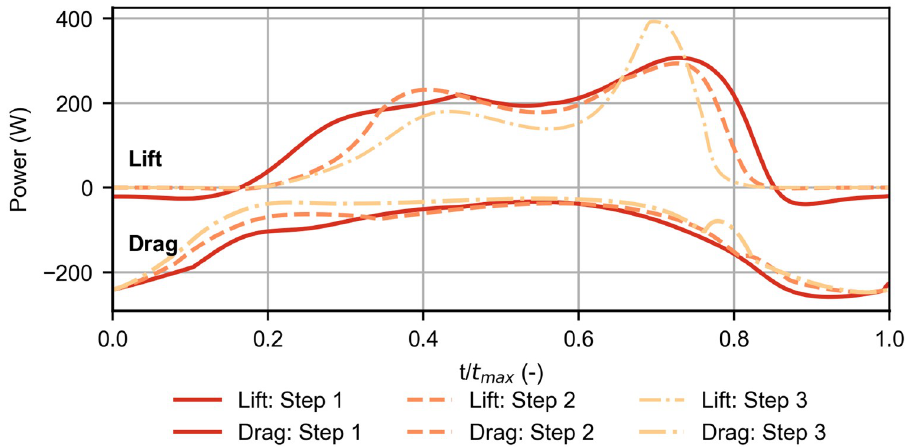
Fig 10. Effect of the transition height. Evolution of energy rates associated to lift and drag, for different transition heights of the step wind profile.